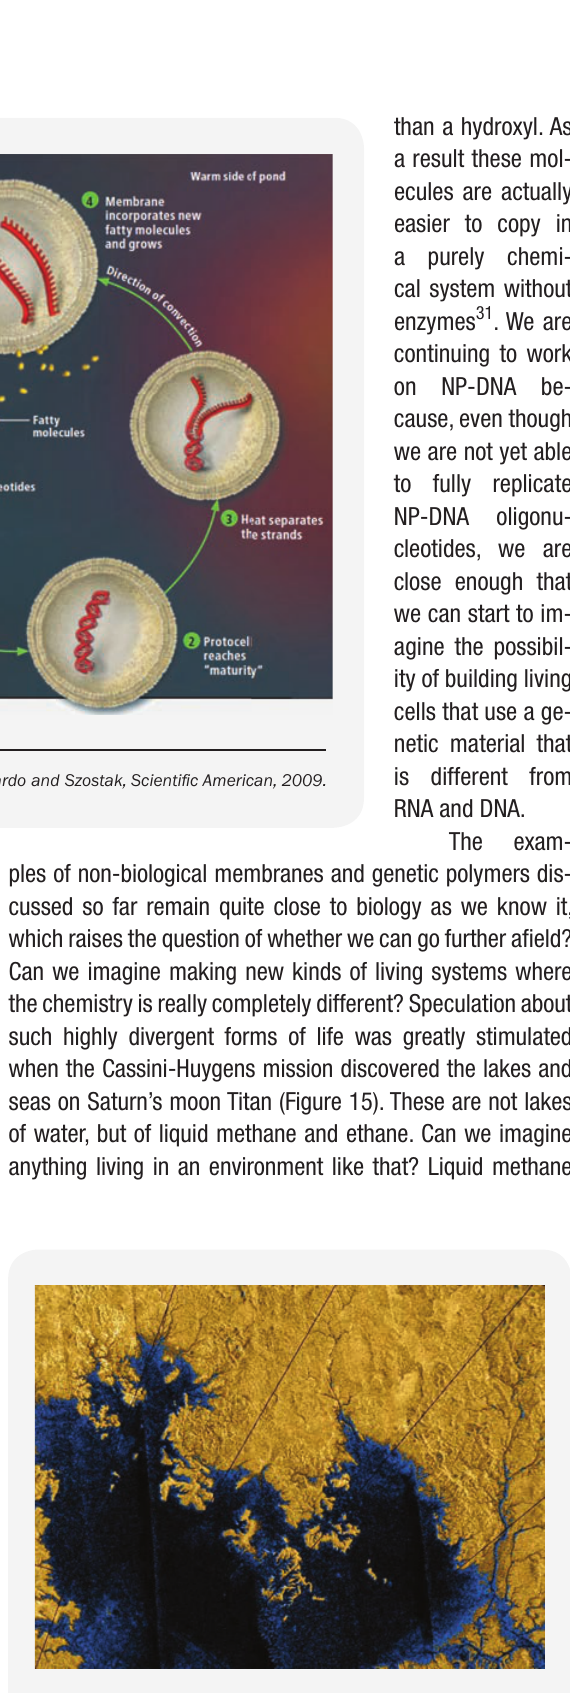
Figure 15. Lakes of methane and ethane on the surface of Saturn’s moon, Titan. Could there be life in such